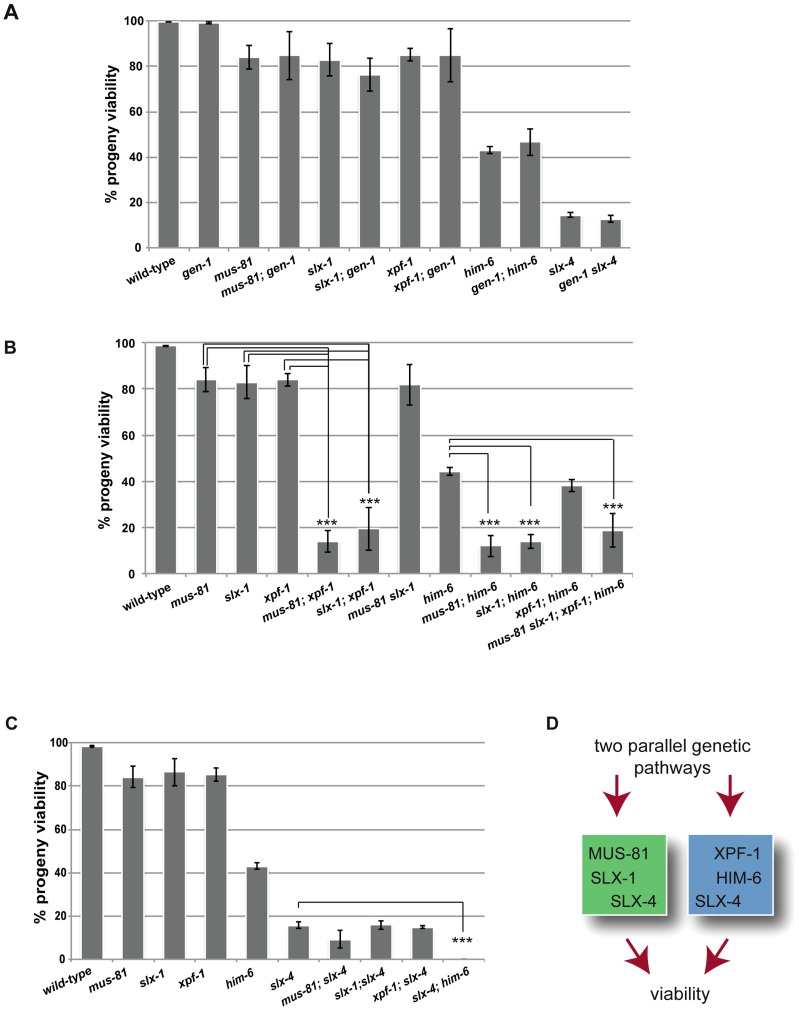
Dissection of genetic interactions between gen-1, mus-81, slx-1, xpf-1, him-6 and slx-4.(A) gen-1 does not alter viability, alone or in conjunction with nucleases, slx-4 or him-6. Progeny viability in % was determined as described in Material and Methods. (B) Evidence for MUS-81/SLX-1 and XPF-1/HIM-6 acting in two genetic pathways. Scoring was done as in A. For double mutants with reduced viability the F1 progeny of double homozygous mothers derived from hT2-balanced lines was scored (for strain list see Materials and Methods). In contrast slx-1; him-6 double mutants derived from a strain were him-6 is balanced by nT1 behave as synthetic lethal (data not shown) [47]. We think that this lethality is due the nT1 balancer, which has been described as prone to brake down, as preferably segregating to the male germ line and as conferring a reduced brood size [88]. (C) Reduced progeny viability of slx-4 is not enhanced by nuclease mutations. (D) Genetic model. Asterisks indicate statistical significance between different genotypes as determined by two-tailed Mann-Whitney test (*** indicates P<0.01).